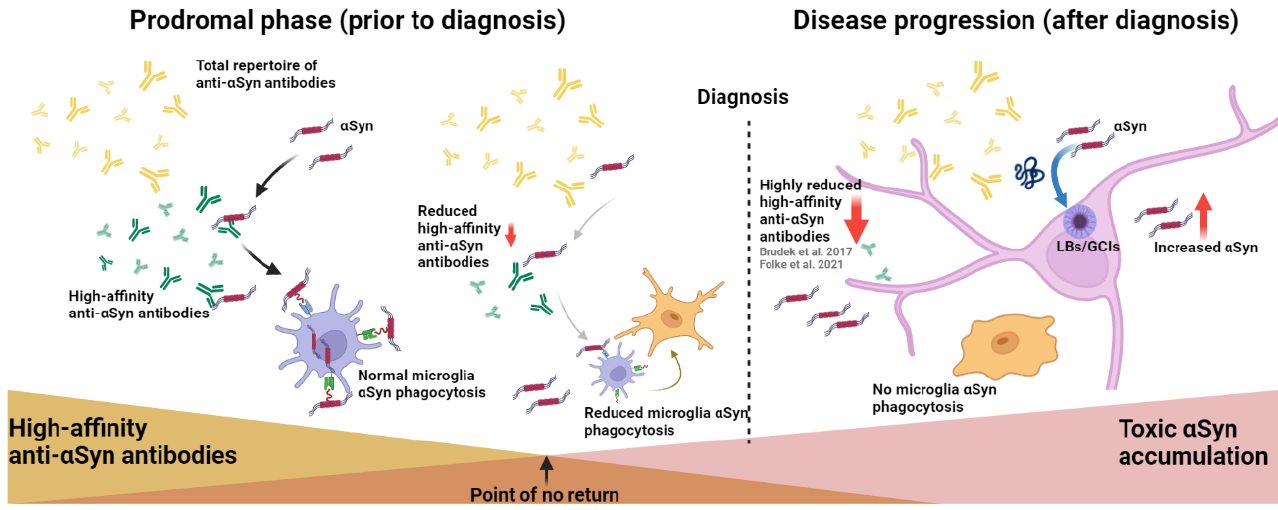
Figure 4. Proposed hypothesis of specific anti- α Syn nAbs decline by proxy facilitating an increase of α Syn following prodromal phases of MSA and PD and post diagnosis. nAbs, normally implicated in the clearing processes of excess amounts of α Syn inhibiting pathogenic species (oligomeric, protofibrils and fibril structures e.g., Lewy bodies (LBs) and Glial cytoplasmic inclusions (GCIs)) accumulation and interrupting α Syn seeding properties. Intervention with anti- α Syn nAbs could facilitate clearance of pathogenic α Syn.